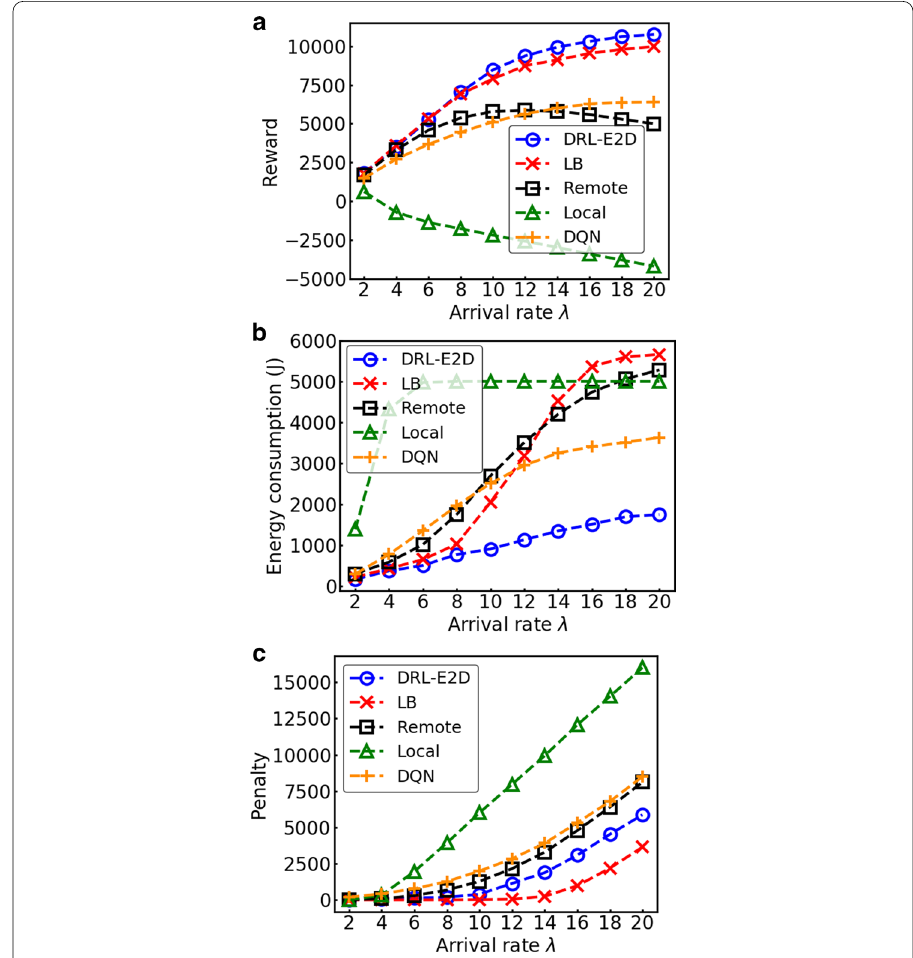
Fig. 7 The performance impact of (cid:31) . a Reward. b Energy consumption. c